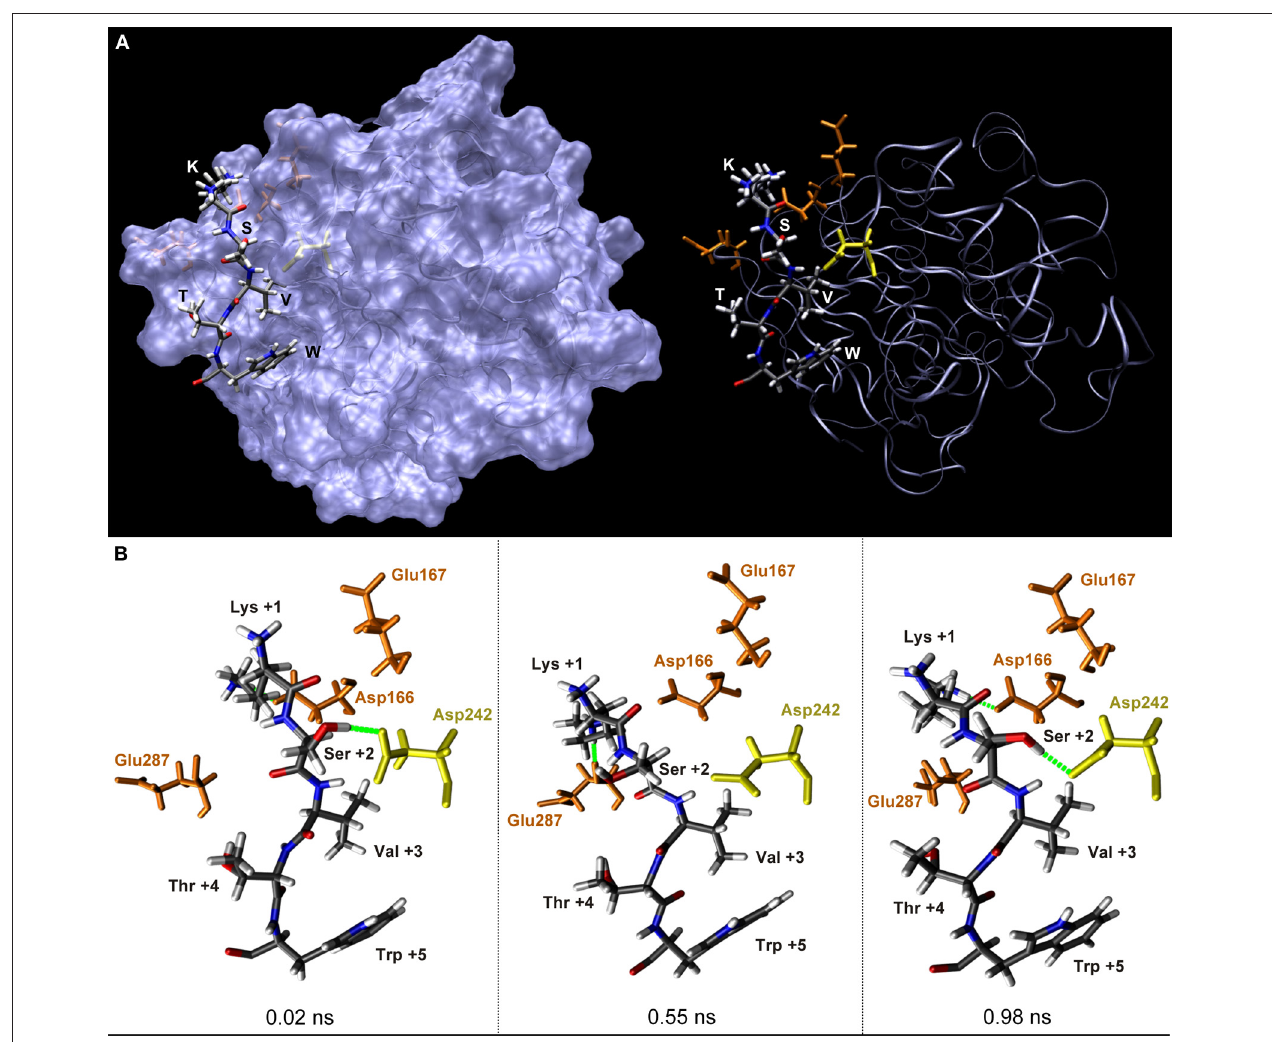
in brown, Asp242 of PP1 γ 1 contacting Ser + 2 is marked in yellow. Val + 3 and Trp + 5 are buried in hydrophobic pockets of the PP1 γ 1 surface and the side chain of Thr + 4 points to the opposite direction. (B) Enlarged views of the KSVTW ligand sequence at 0.02ns, 0.55ns, and 0.98ns of molecular dynamics simulation time, as indicated. Green dotted lines represent important electrostatic interactions formed by Lys + 1 and Ser + 2 with PP1 γ